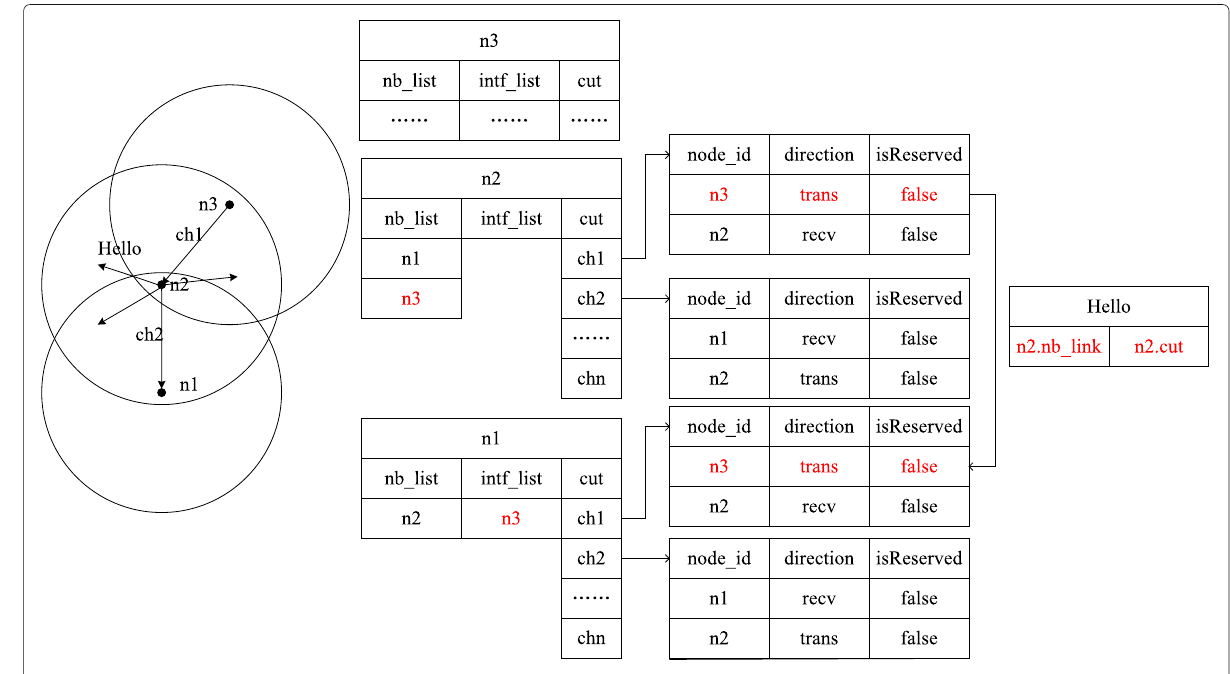
Fig. 2 The example of neighboring